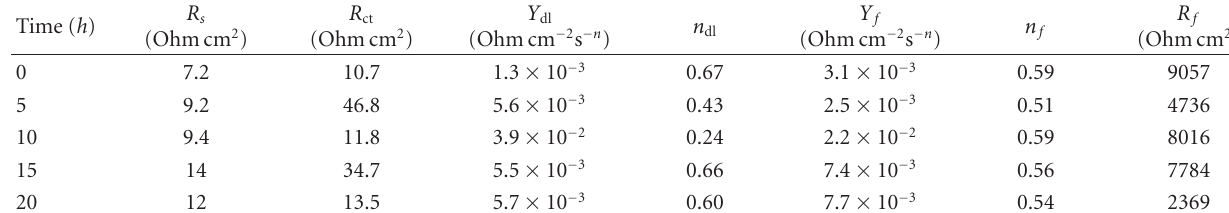
Table 3: Parameters used to simulate the EIS data for Fe- 40Al-2.5Ti alloy.